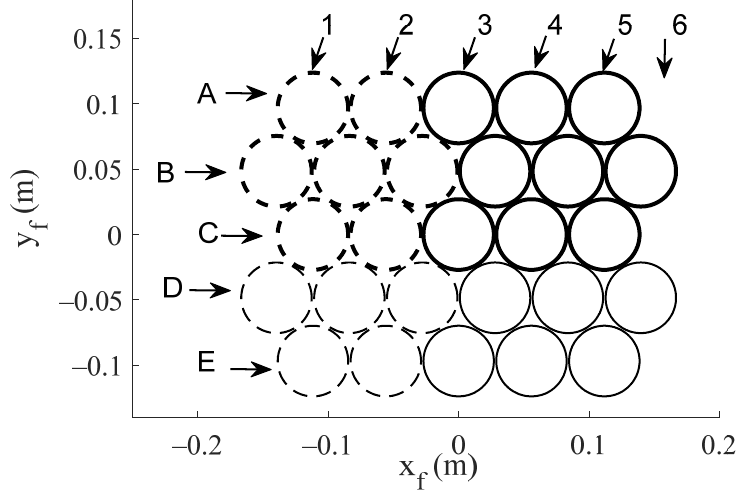
Figure 3. Cluster of 27 feeds defined to illuminate the different antenna farms.